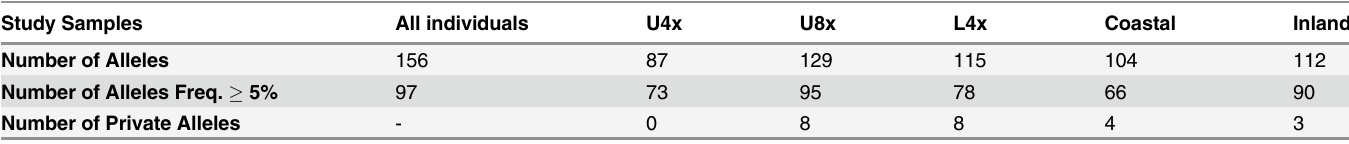
Table 2. Performance of 18 SSR markers in switchgrass. Study Samples All